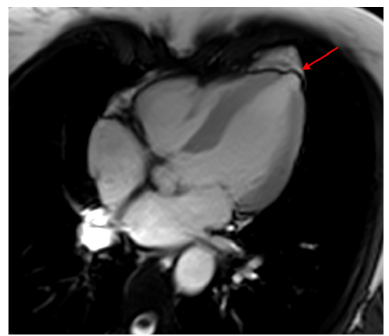
Figure 2. Cardiac magnetic resonance (CMR) four chamber image showing a typical left ventricular mamillar apical aneurysm (arrow). CMR: cardiac magnetic resonance.